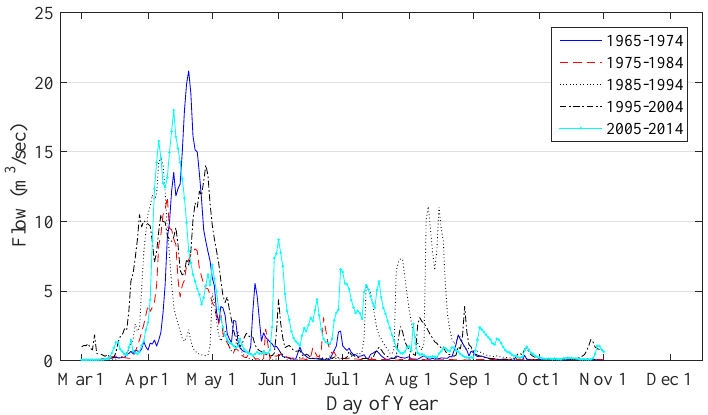
Figure 2. Flow data (1965–2014): average of ten-year segments at the Sturgeon Creek (#05MJ004) gauging